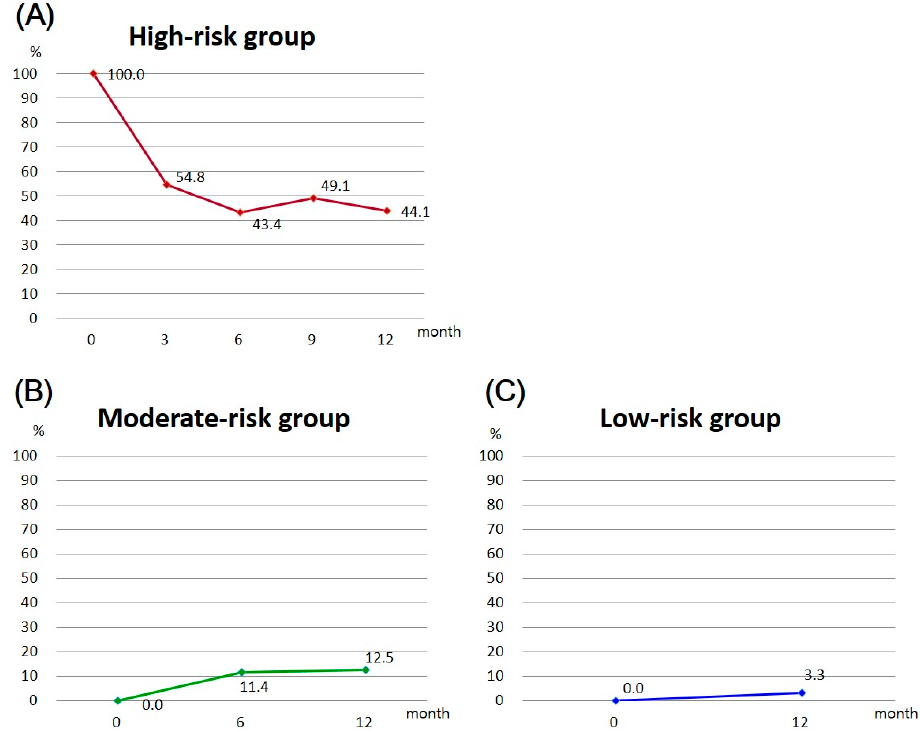
Figure 1. Changes in the prevalence of metabolic syndrome by group, over the SMESY intervention. ( A ) Changes in the prevalence of metabolic syndrome in the high-risk group; ( B ) Changes in the prevalence of metabolic syndrome in the moderate-risk group; ( C ) Changes in the prevalence of metabolic syndrome in the low-risk